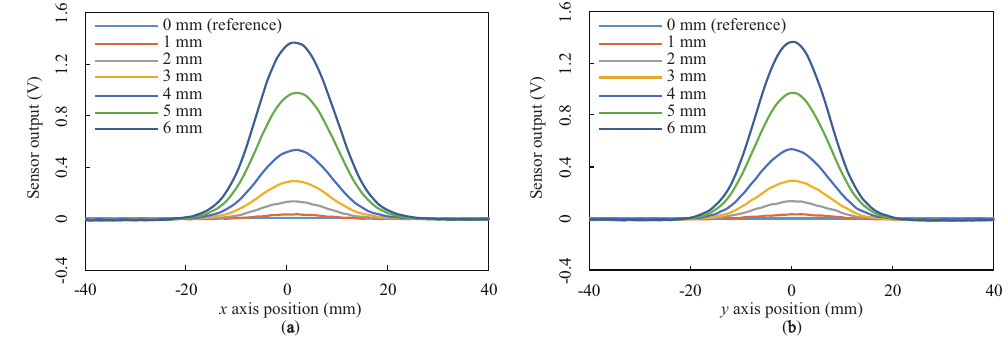
Figure 12. Line profiles of the measured spatial responses with the sponge sheet instead of the base elastomer sheet: ( a , b ) Sensor outputs along the x and y axes through the point ( x os , y os ) = (2, 0),